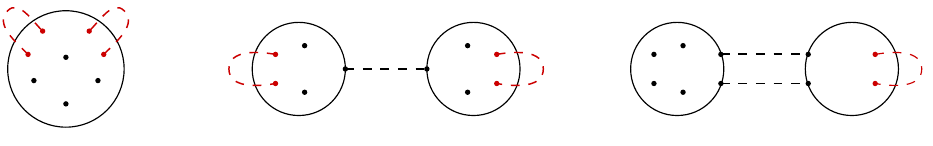
Figure 16 . Three types of degeneration of a genus-two